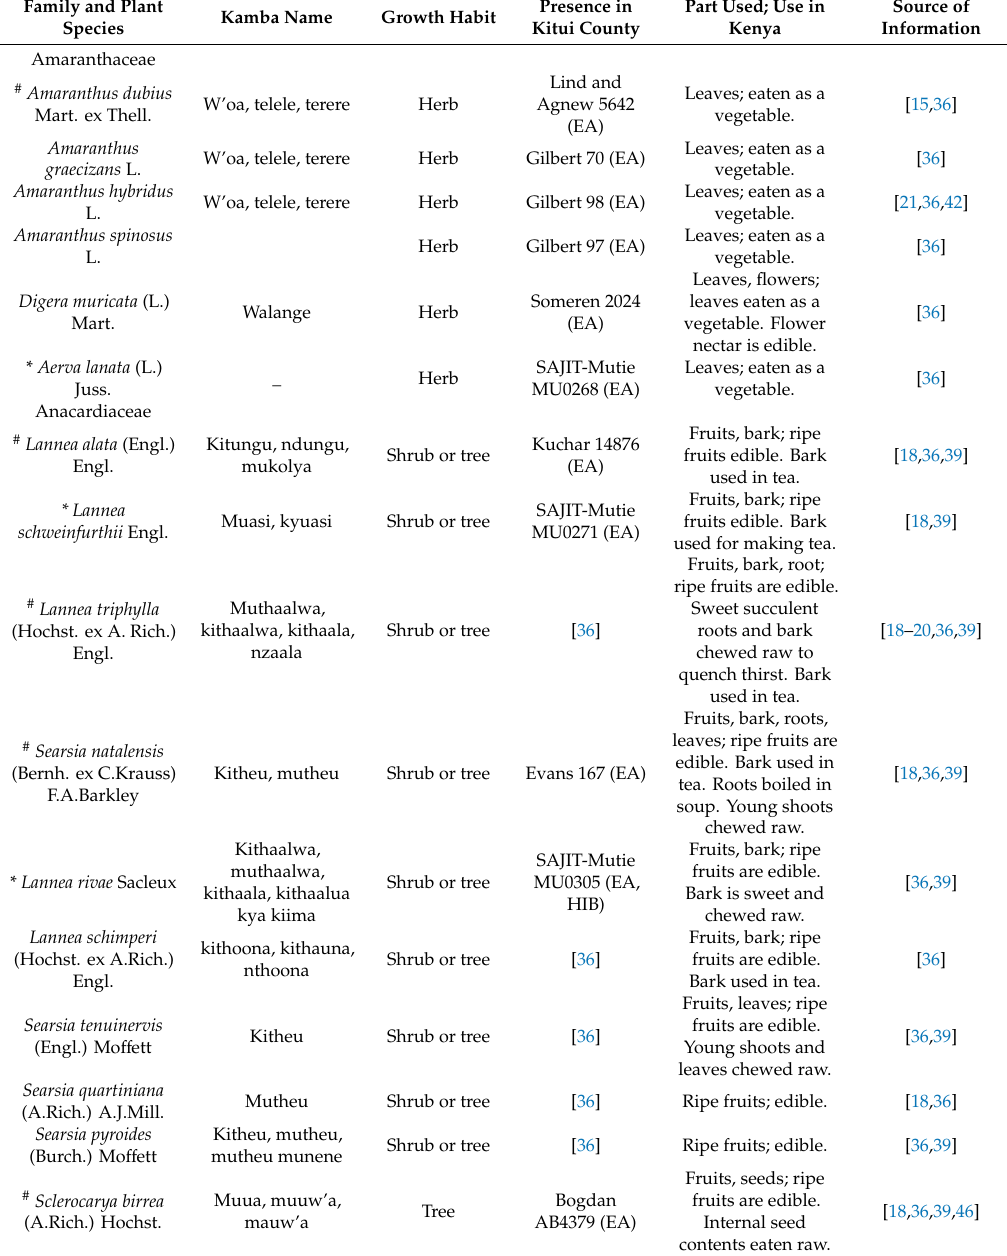
Table 3. An inventory of wild edible plant species occurring in Kitui county. Information given under ‘presence in Kitui county’ refers to voucher specimens collected during field work by the authors (designated as SAJIT-Mutie MU), specimens at the East African (EA) herbarium or in publications citing the presence of the species in Kitui county. The plant use information refers to records of use of the plants for anywhere in Kenya, not necessarily in Kitui county, unless the name of the species is accompanied by an Asterix (*) (indicating the plant was cited during a field survey as edible) or by a number sign (#) indicating the plant use in Kitui county was obtained from